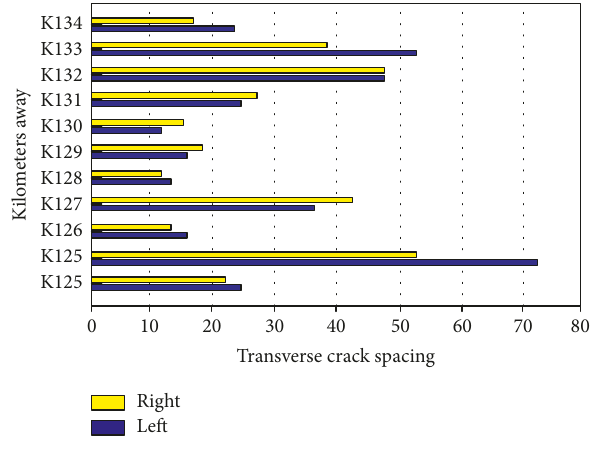
Figure 4: Distribution of crack